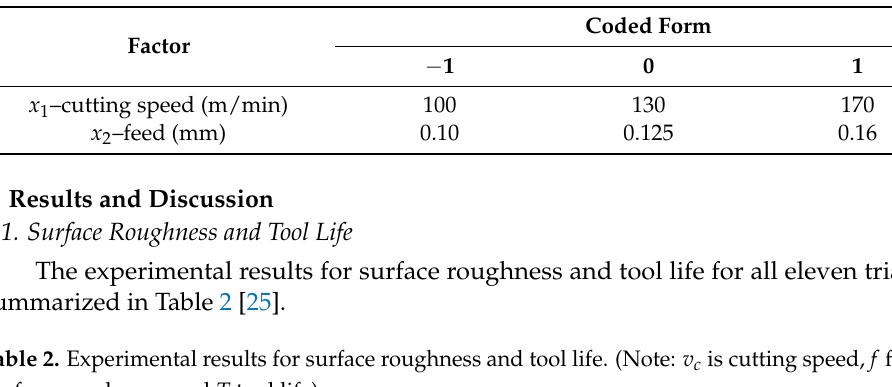
Table 1. Factor and levels for the experiments.